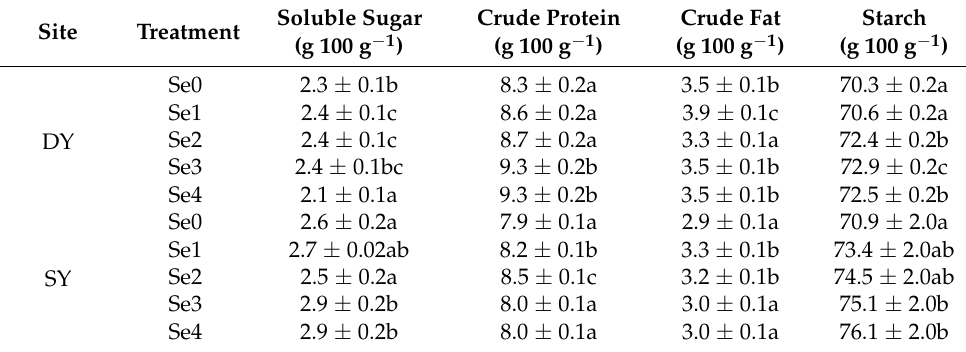
Table 8. Effects of Se fertilizer application on quality of maize at locations DY and